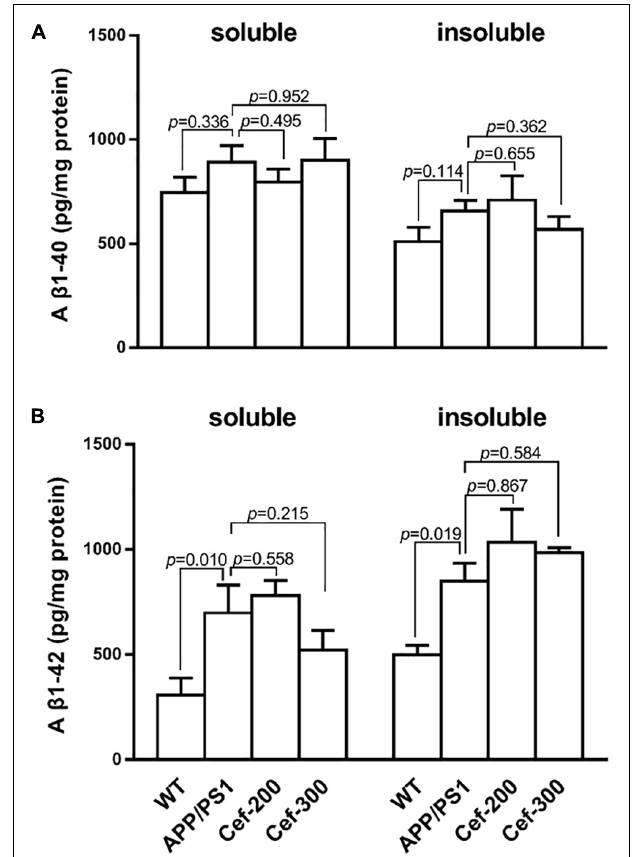
FIGURE 5 | Cef has no effect on A β levels in the hippocampus of APP/PS1 mice. (A) Is the assay of soluble and insoluble A β 1 - 40 levels in each group, and (B) is the soluble and insoluble A β 1 - 42 levels. The number of mice for each test is shown in Table 1 . The italic values upon the bars are statistical P